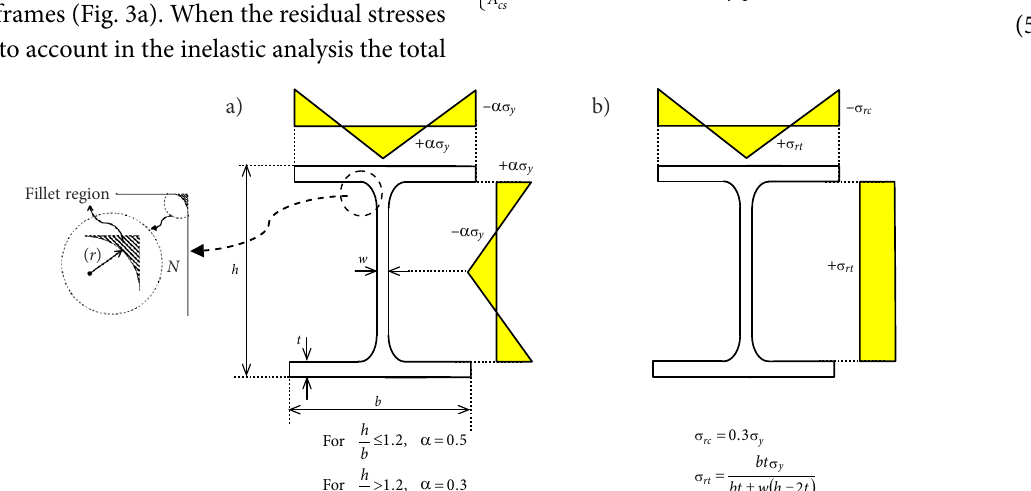
Fig. 3. Residual stress ( s